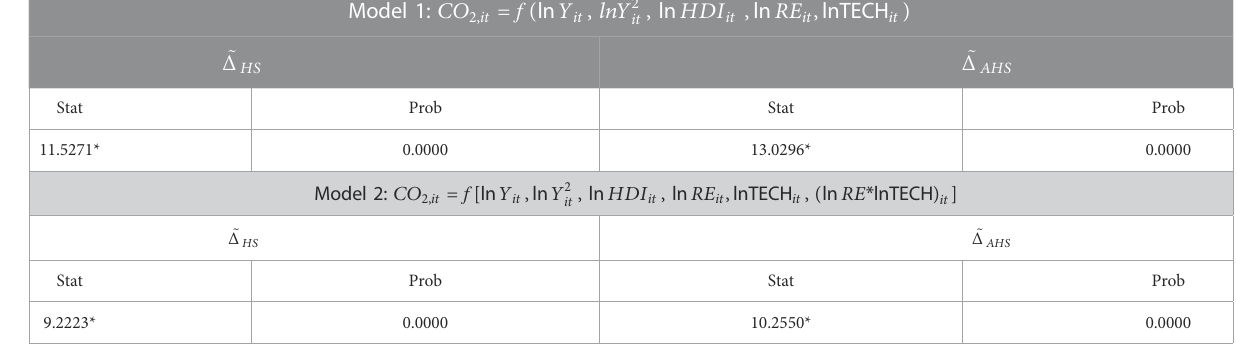
TABLE 4 Slope-homogeneity test